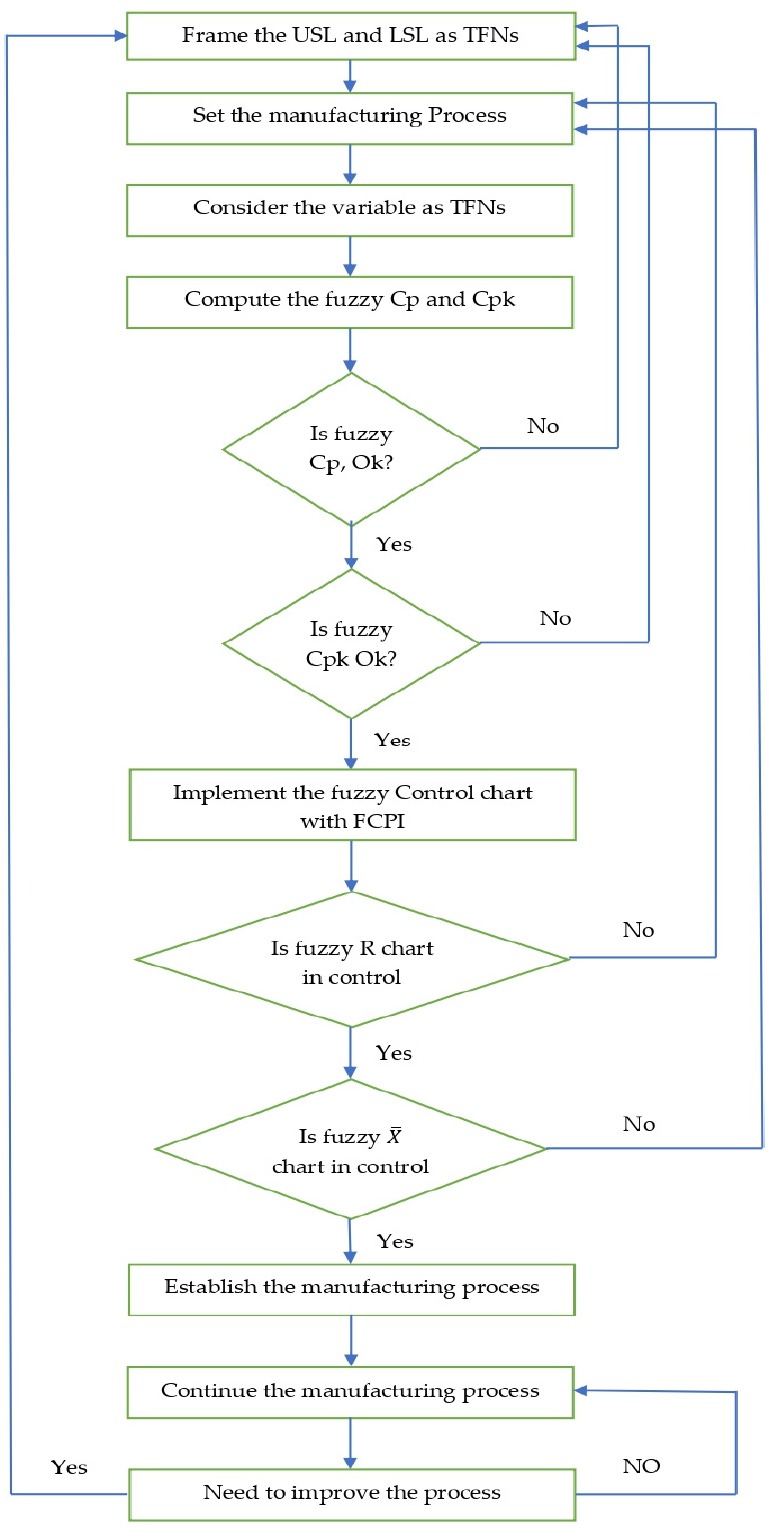
Figure 2. Flow control chart of the proposed technique.